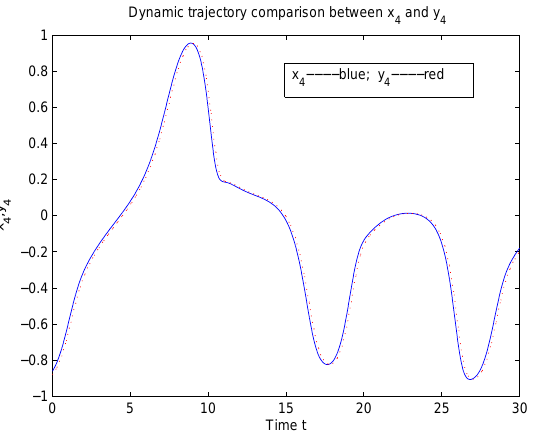
Figure 7. Computer simulations of synchronization between x 4 and y 4 for fractional-order 0.95. Example 2. Set α = 1 in System (5) and (2) . Equip System (2) and System (5) with the